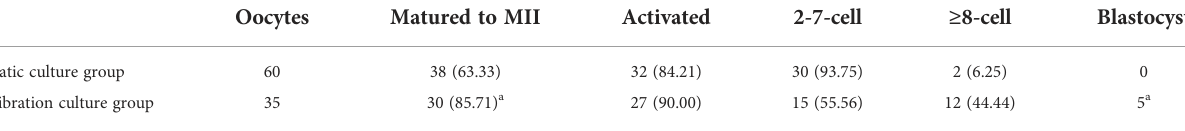
TABLE 1 Activation and parthenogenetic embryonic development of oocytes matured in vitro